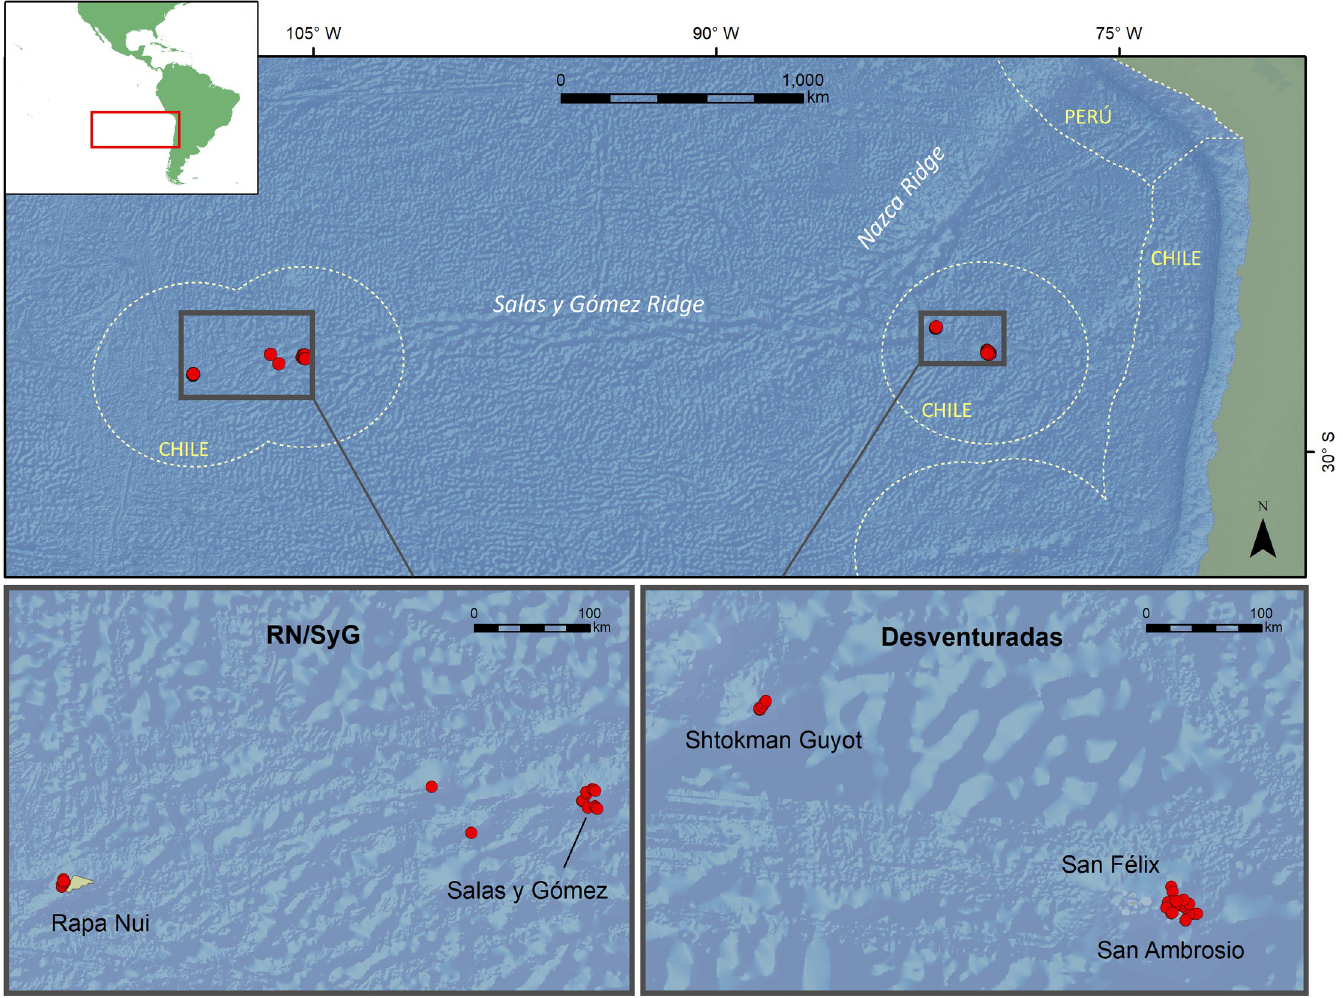
Fig 1. Deep-sea camera system deployments on the Salas y Go´mez and Nazca ridges. Dotted lines depict exclusive economic zones (EEZs). Red dots depict camera deployment sites. Bathymetric data source: GEBCO Compilation Group (2020) GEBCO 2020 Grid (doi:10.5285/a29c5465-b138-234de053-6c86abc040b9).